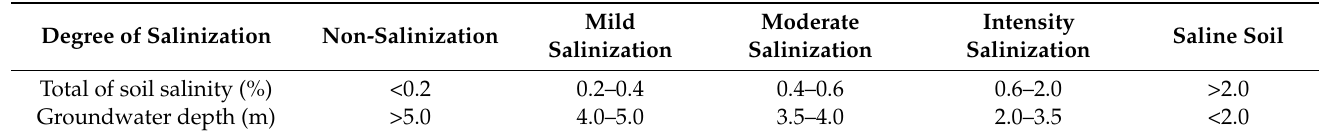
Table 5. Classification of soil salinization and corresponding groundwater depth.